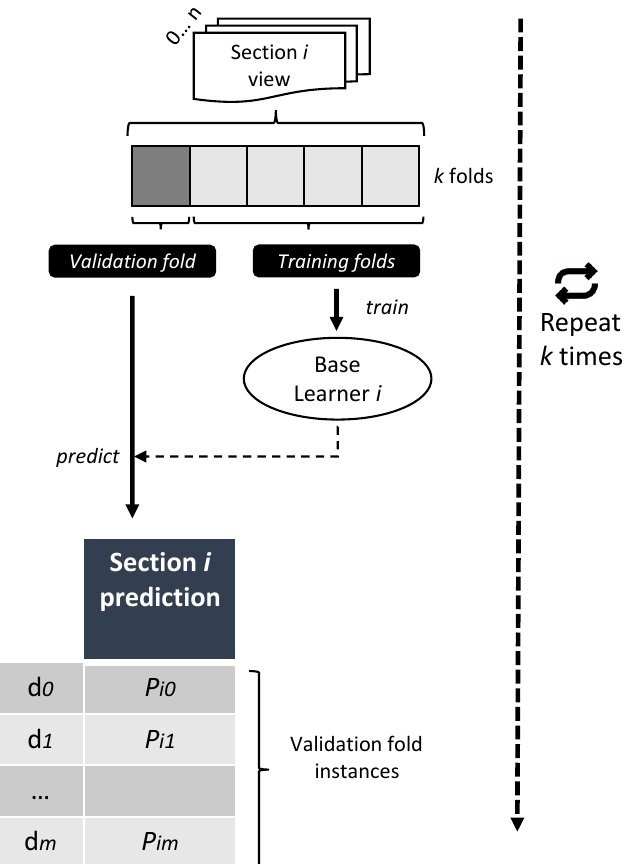
Figure 2. Meta-learner training dataset creation.